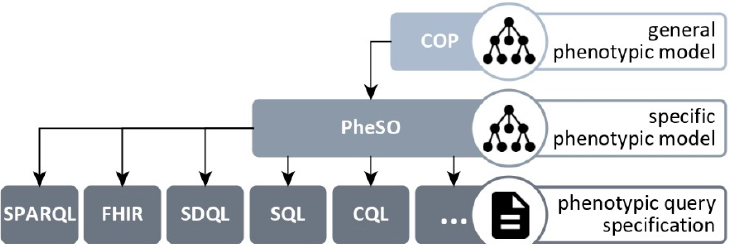
Figure 1. Overview of the components used to build phenotypic queries. The Core Ontology of Phenotypes (COP) serves as a general phenotypic model and is used by Phenotype Specification Ontologies (PheSO) to build use case-specific models that can be converted to queries.